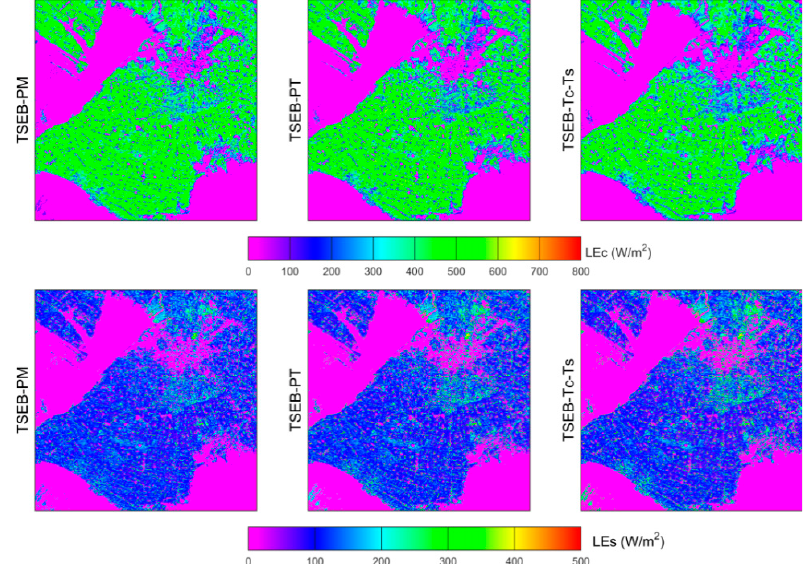
Figure 4. The spatial distribution of LE c (first row) and LE s (second row) over the Zhangye oasis based on TSEB-PT, TSEB-PM, and TSEB- T C - T S for the satellite overpass time on 10 July 2012.